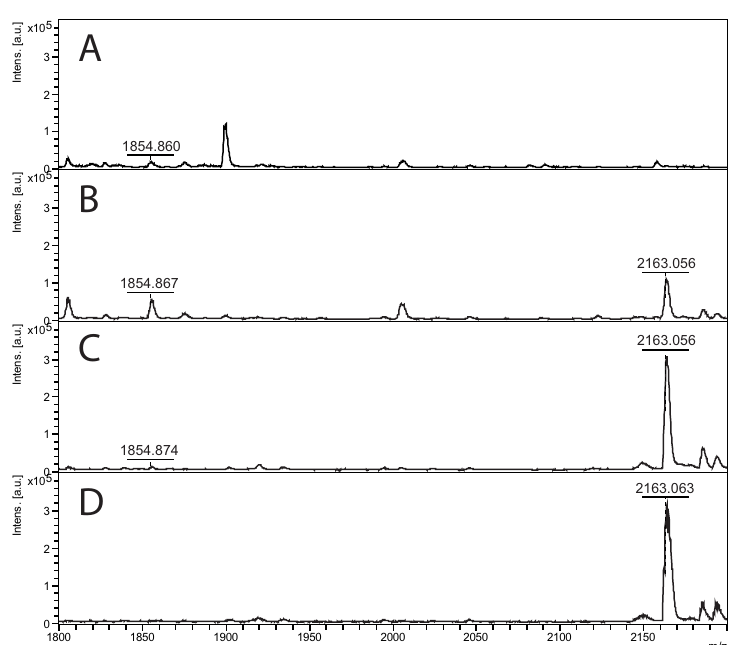
Fig 6. MALDI-MS of trypsin digests of elution fractions with 20 μ g/ml rhOPN in human plasma. (A) PB-Gly pH 4.4 + 0.1 M NaCl, (B) PB-Gly pH 4.4 + 0.2 M NaCl, (C) PB-Gly pH 4.4 + 0.3 M NaCl, (D) PB-Gly pH 4.4 + 0.4 M